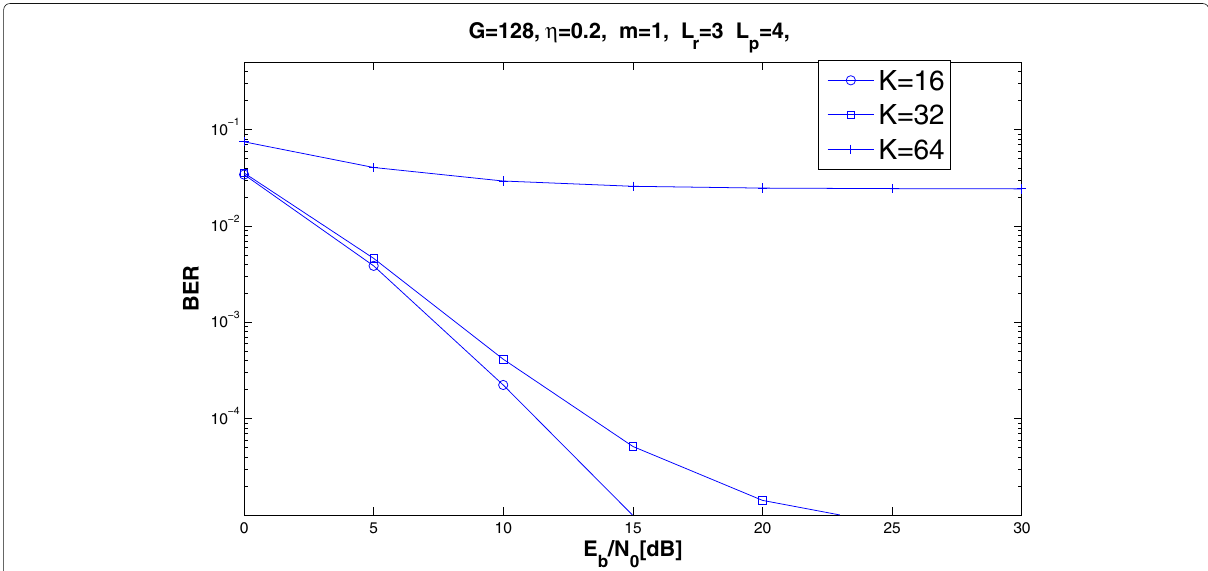
Fig. 7 BER performance of the CDD communication system with various number of users K